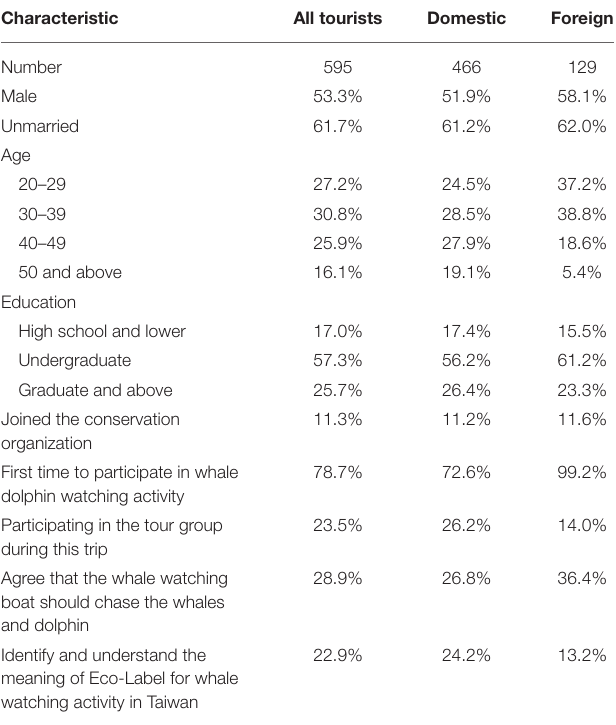
TABLE 2 | Tourist’s demographics distribution in whale and dolphin watching sites.